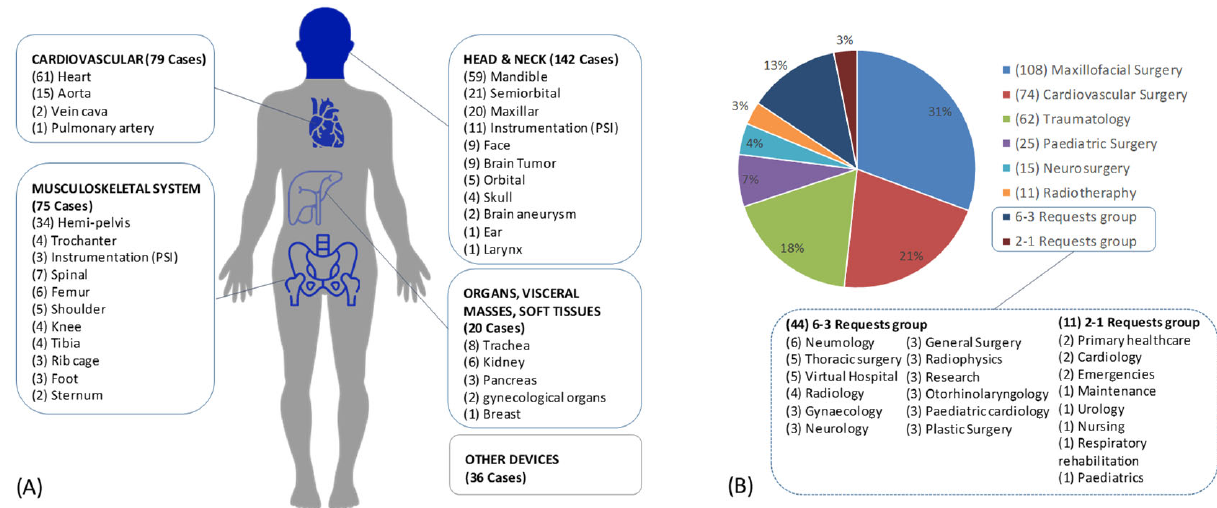
Figure 7. ( A ) Number of requests ranked by anatomy, grouped into 4 types of systems: head and neck, cardiovascular, musculoskeletal and soft tissues. Another group with other types of requests is also indicated. ( B ) Percentage and number of requests received by each hospital department. A total of 27 departments made at least one request. The departments with the fewest requests were grouped together: a group with 3 to 6 requests and a group with 1 or 2 requests. This figure was designed using resources from www.flaticon.com, accessed on 17 July 2022. Table 1. Type of uses of requests for 3D models.